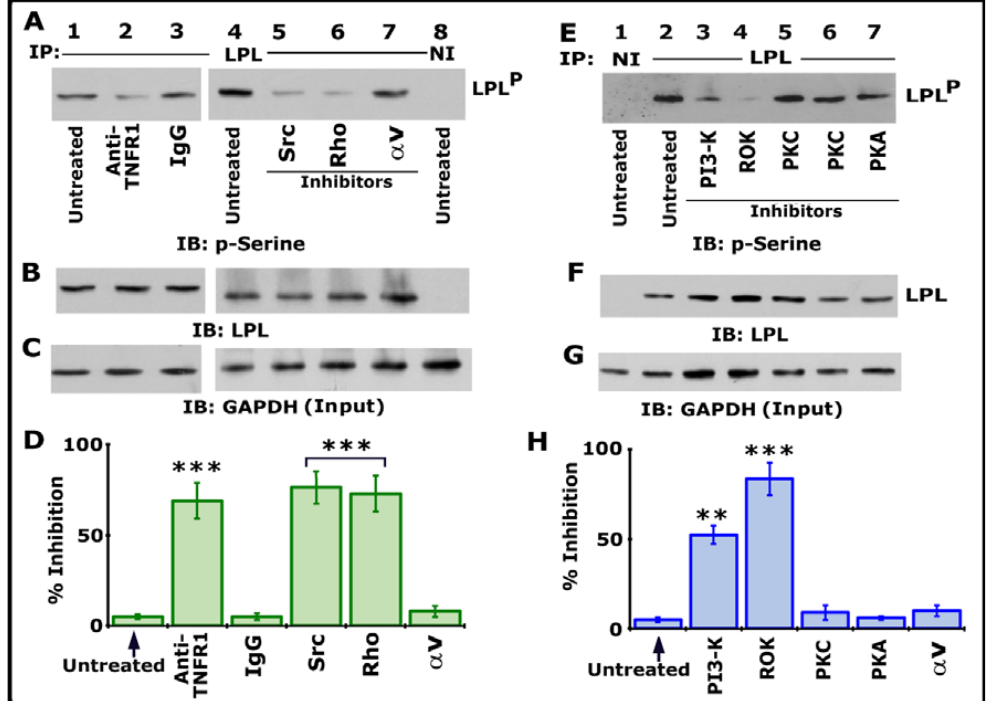
Figure 2. Immunoblotting (IB) analyses in lysates made from osteoclasts treated with various treatments. Osteoclasts untreated (lanes 1 and 4) or treated with IgG (lane 3) were used as controls. All cultures were incubated with TNF- α and bone particles for 3 h. ( A – C ) Lysates made from osteoclasts treated with anti-TNFR1 (lane 2); species-specific IgG (lane 3); or inhibitors of Src (PP2), Rho (C3), or integrin α v (cyclo RGD peptide) (lanes 5–7) were immunoprecipitated with an antibody to LPL ( A , 1–7) or nonimmune serum (NI; lane 8) for IB analysis with a p-serine antibody ( A ). LPL P represents phosphorylated LPL. Then, the blot was stripped and immunoblotted with an antibody to LPL to determine the immunoprecipitated levels of LPL ( B ). Finally, direct immunoblotting of the lysates with a GAPDH antibody in ( C ) demonstrated that an equal amount of total protein (Input) was used for immunoprecipitation with LPL ( C ). ( E – G ) Lysates made from osteoclasts treated with inhibitors of PI-3K (Wortmannin), Rho kinase (Y27632), PKC (Staurosporine or Go6983), or PKA (H89) (lanes 3–7) were immunoprecipitated with an antibody to LPL ( E , 2–7) or nonimmune serum (NI; lane 1) for IB analysis with a p-serine antibody ( E ). The blot was then stripped and immunoblotted with an antibody to LPL to determine the immunoprecipitated levels of LPL ( F ). Immunoblotting of the lysates with a GAPDH antibody in panel G indicates the total protein (Input) used for immunoprecipitation with LPL ( C ). ( D , H ) Percent inhibition of phosphorylation of LPL (~68–70 kDa) is provided as a graph. The resulting LPL P -to-LPL ratio was used for the quantitative analyses. *** p < 0.001; ** p < 0.01 versus untreated osteoclasts. Values shown are mean ± SEM of three different immunoblots. The results shown are one of the three experiments performed with similar results. Uncropped images are provided in the Supplementary